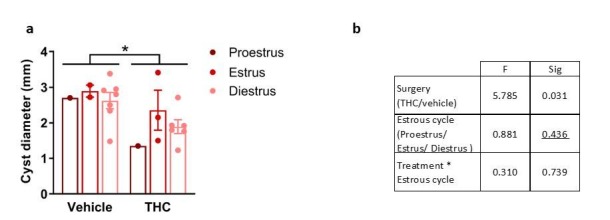
Effects of THC and stage of the estrous cycle on cyst diameter.(a) Cyst diameter in the different group treatments and estrous cycle stages. A significant effect of the treatment was found. (b) Significance of the effects according to a Two-way ANOVA. Error bars are mean ± SEM. *p<0.05 vs vehicle. Endo, endometriosis.